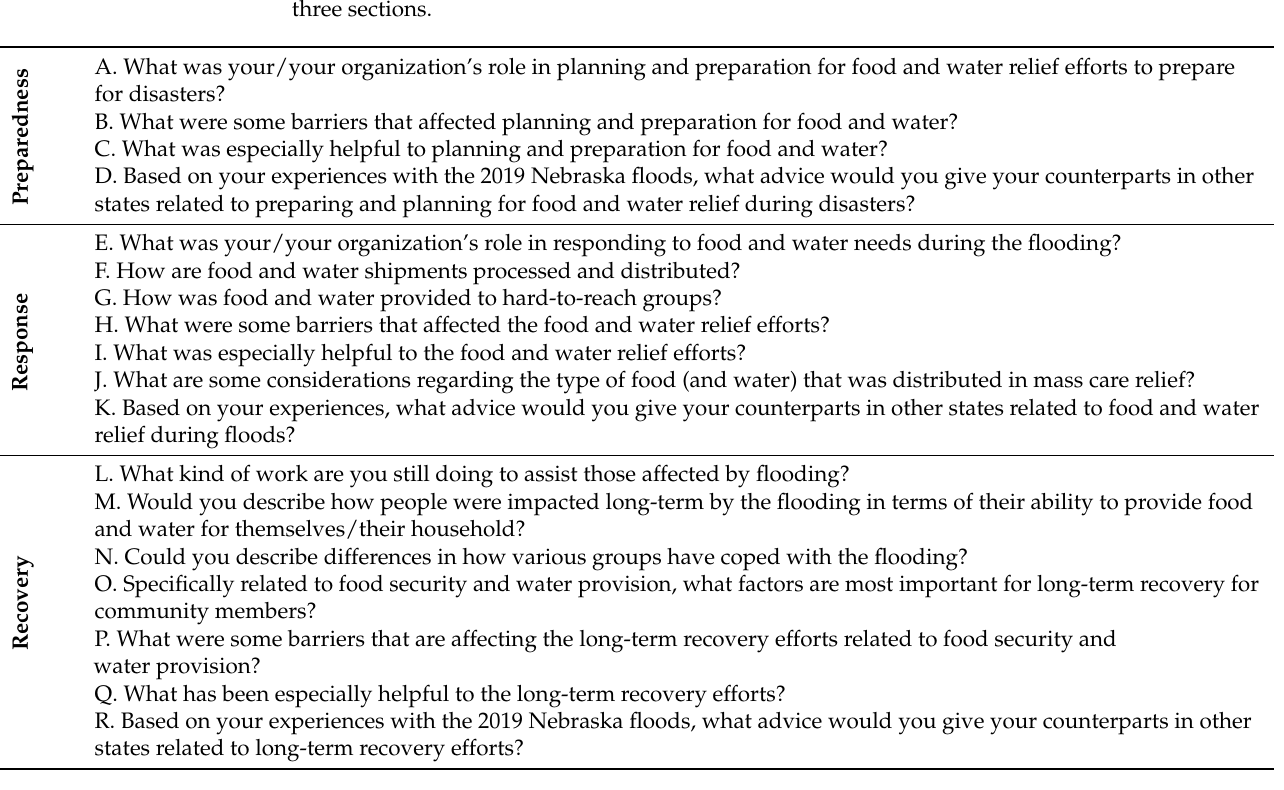
Table 2. Primary questions covered during the semi-structured interviews categorized by prepared- ness, response, and recovery sections, with mitigation recommendations solicited throughout the three